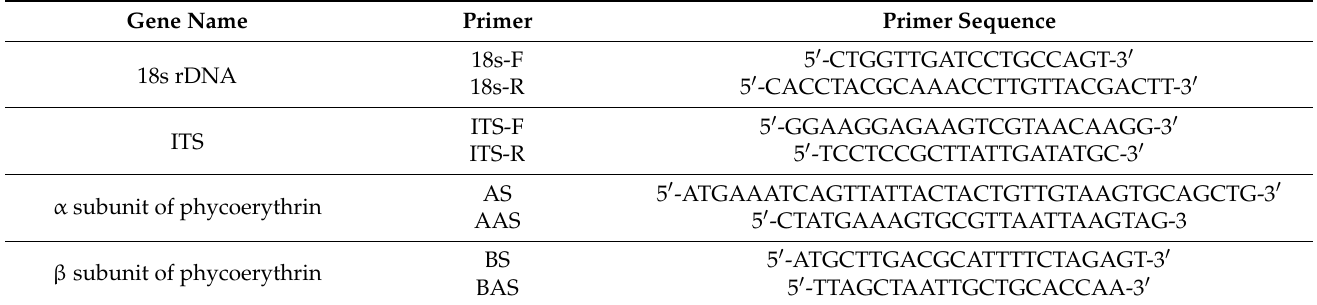
Table 1. Primers for gene sequence